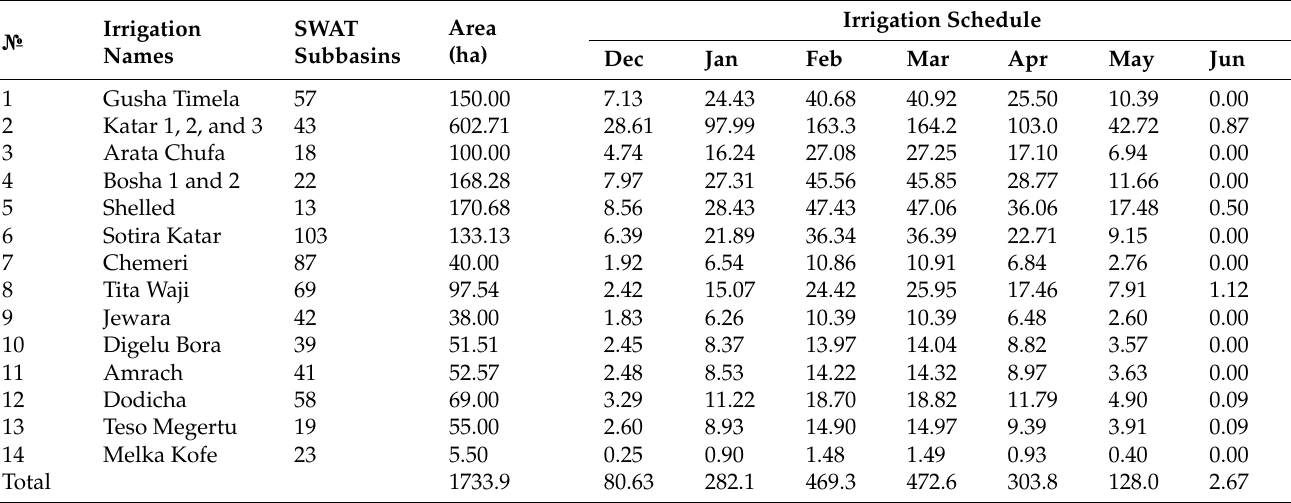
Table 3. Average daily water abstraction for irrigation in 10 −2 MCB estimated using CRIWAR 3.0 software www.bos-water.nl accessed on 12 May 2022 based on the climate, crop characteristics, and general information of each irrigation site.